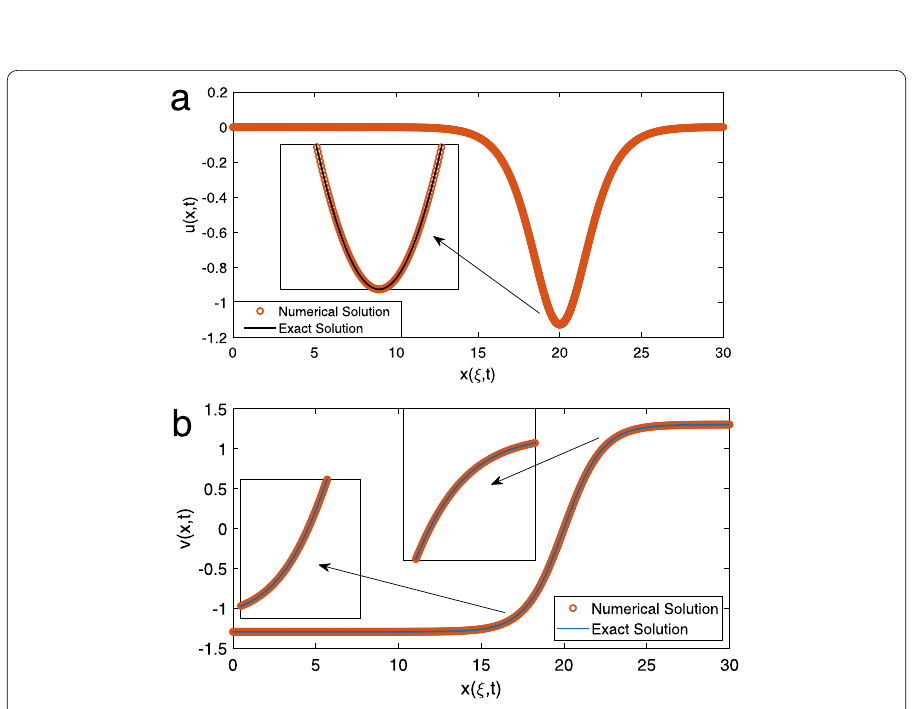
Figure 3 A graphical comparison of the exact and numerical solutions is presented in ( a ) u ( x , t ) and ( b ) v ( x , t ). The exact solutions for both u ( x , t ) and v ( x , t ) seem identical to numerical results. The curvature regions clearly show the match of